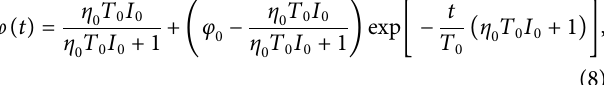
Frontiers in Robotics and AI |